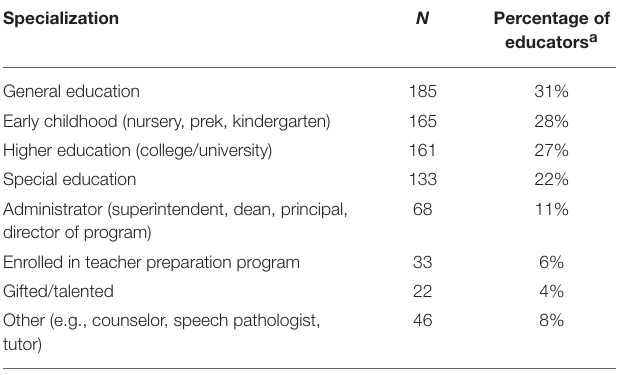
TABLE 2 | Specializations of educator subsample.